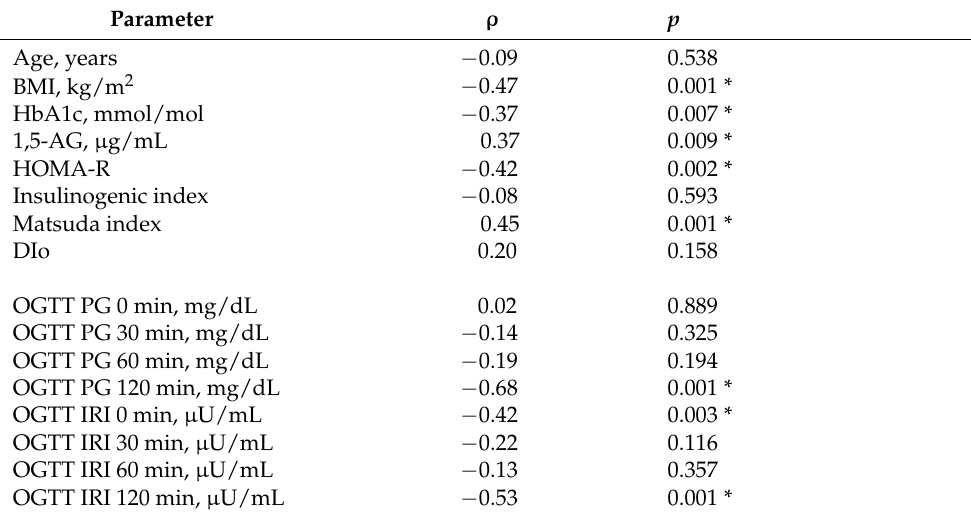
Table 2. Spearman’s rank-order correlation coefficients ( ρ ) of associations between SgIo, and anthro- pometric or biochemical indices.